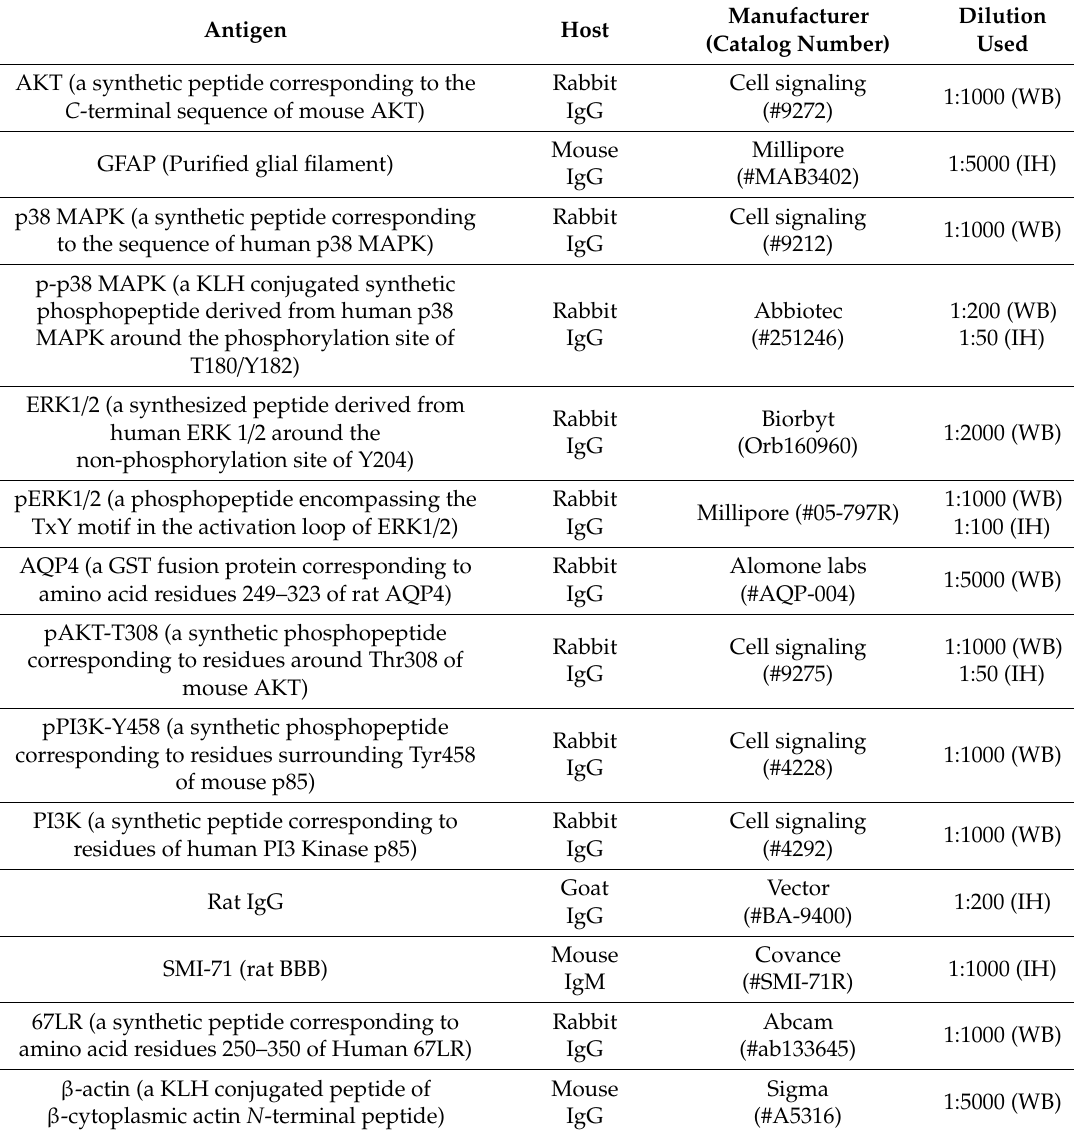
Table 1. Primary antibodies and lectin used in the present